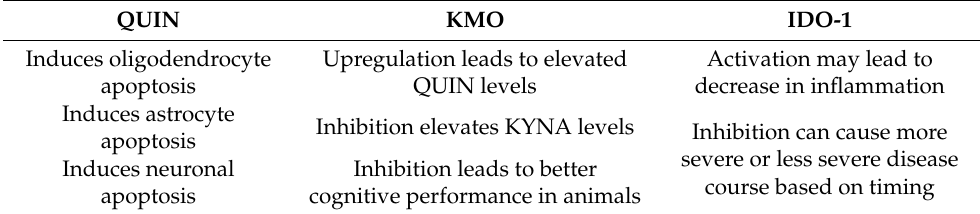
Table 2. Kynurenine pathway metabolites and enzymes—results of in vitro and animal studies. QUIN KMO IDO-1 Induces oligodendrocyte Upregulation leads to elevated Activation may lead to apoptosis QUIN levels decrease in inflammation Induces astrocyte Inhibition elevates KYNA levels Inhibition can cause more apoptosis severe or less severe disease timingInduces neuronal Inhibition leads to better course based on apoptosis cognitive performance in